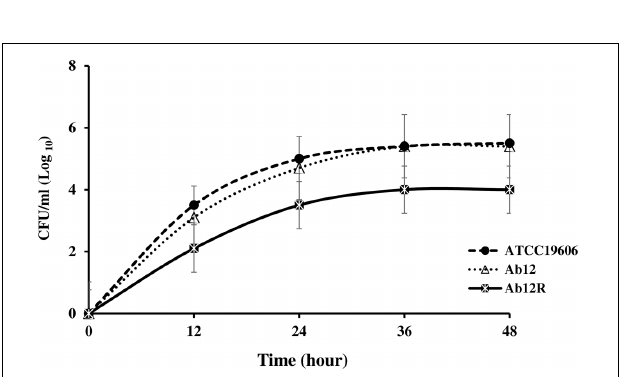
FIGURE 1 | Growth curves of reference strain ATCC 19606 and colistin-susceptible isolate: Ab321 and respective colistin-resistant isolate: Ab328. The growth rates between Col R isolate, Ab328, and their respective Col S isolate, Ab321, were not significantly different at any time points ( P > 0.05).